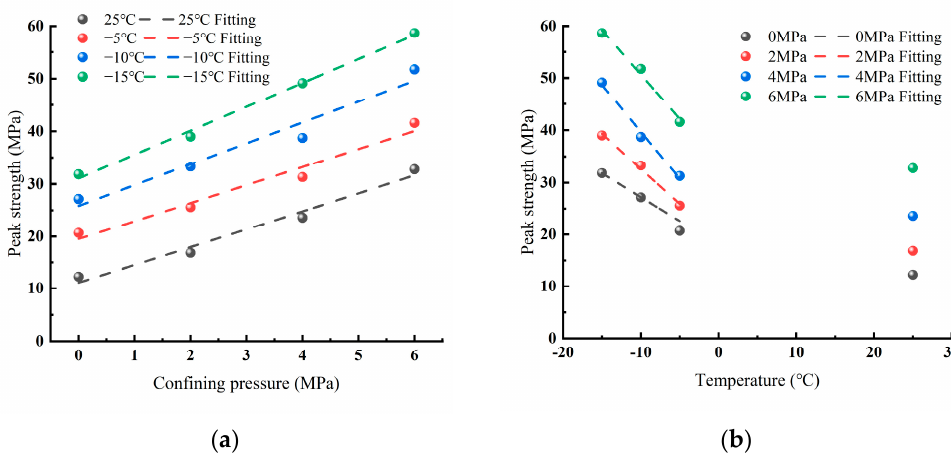
Figure 6. Sandstone peak intensity and the relationship between confining pressure and temperature. ( a ) Relationship between peak strength and confining pressure. ( b ) Relationship between peak strength and temperature.